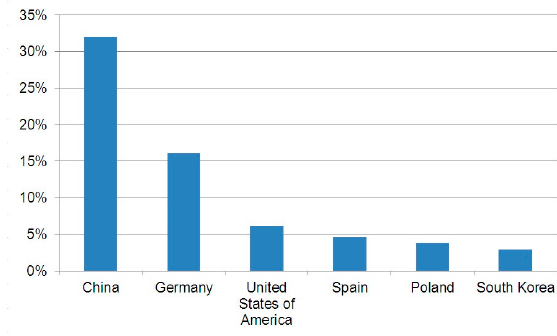
Figure 4. Distribution of publications between the top six subject areas.